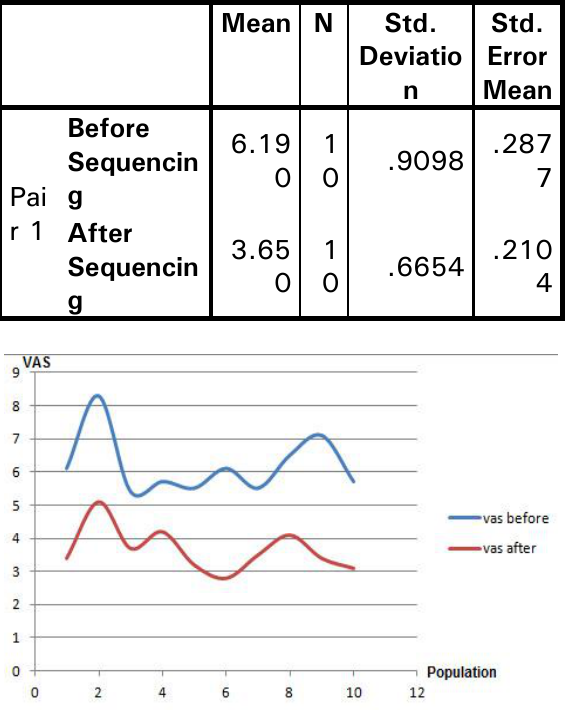
Table 1: Paired sample t-test to show the difference in mean and the standard deviations Mean N Std. Std. Deviatio